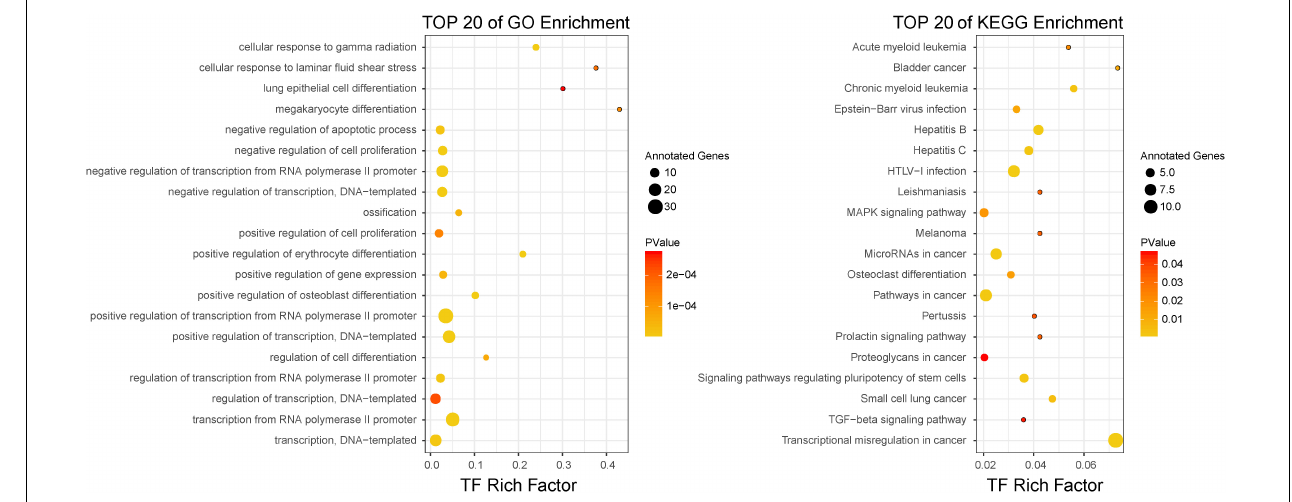
FIGURE 3 | The top 20 GO enrichment results and KEGG enrichment results for top-ranked